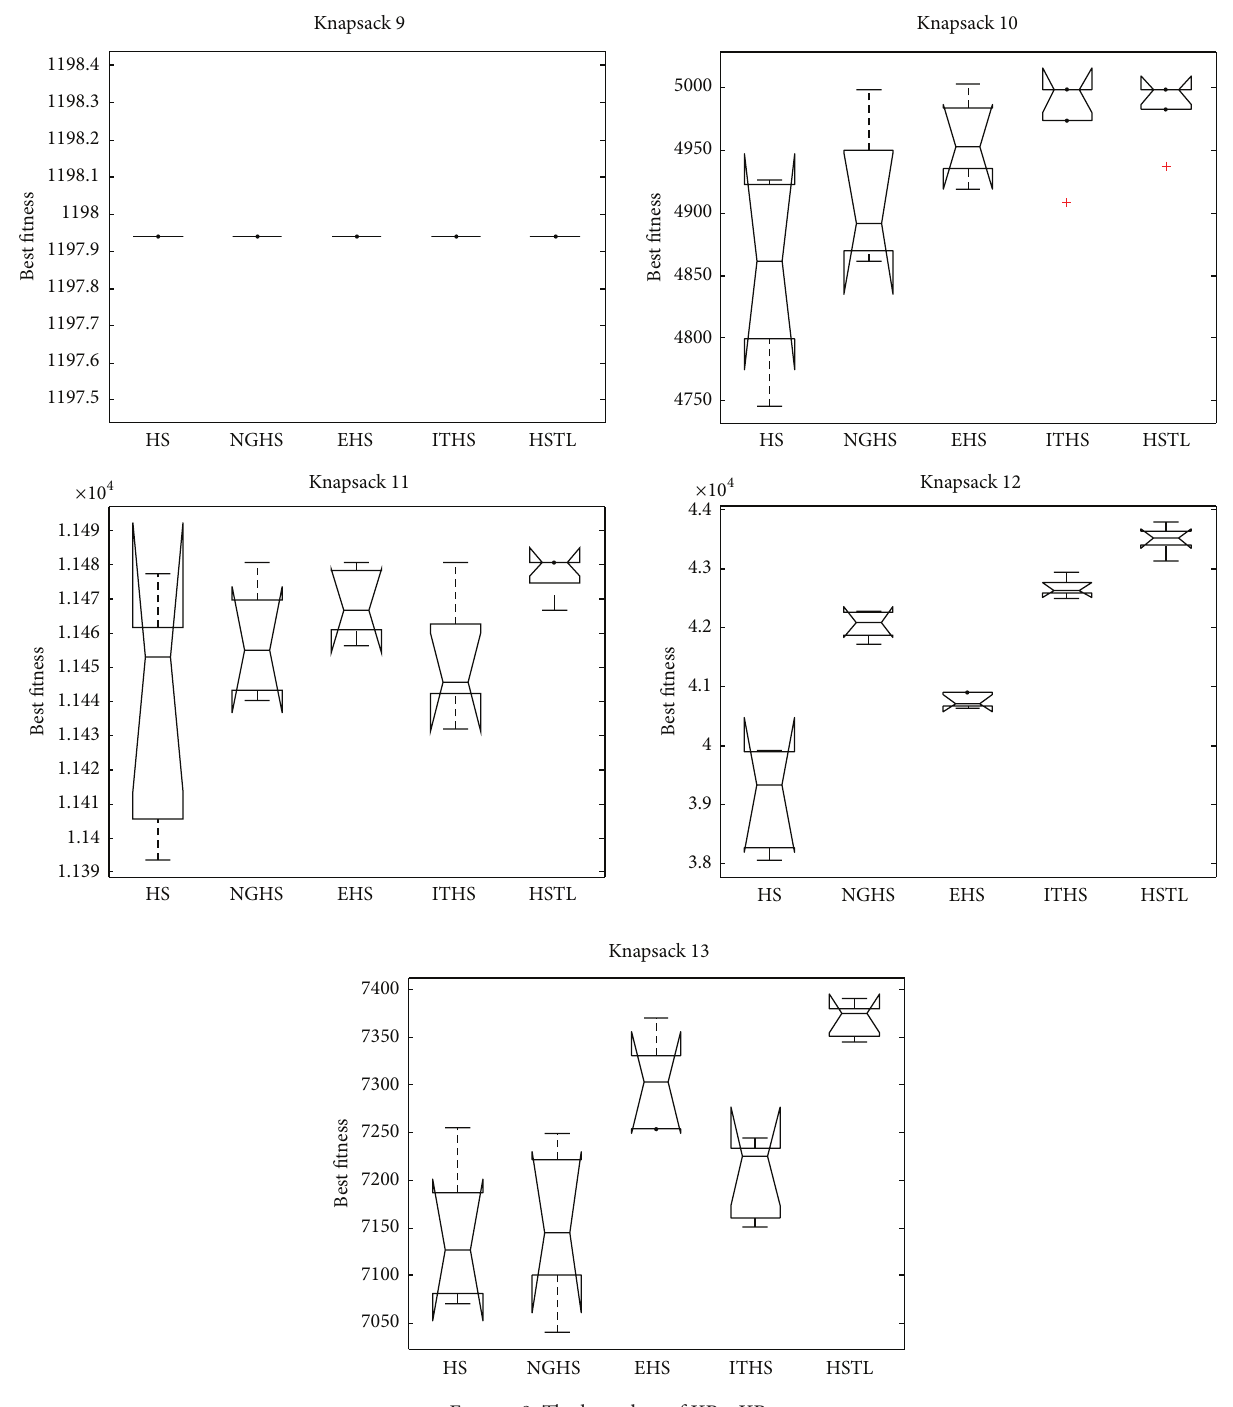
Figure 9: The box plots of KP 9 –KP 13